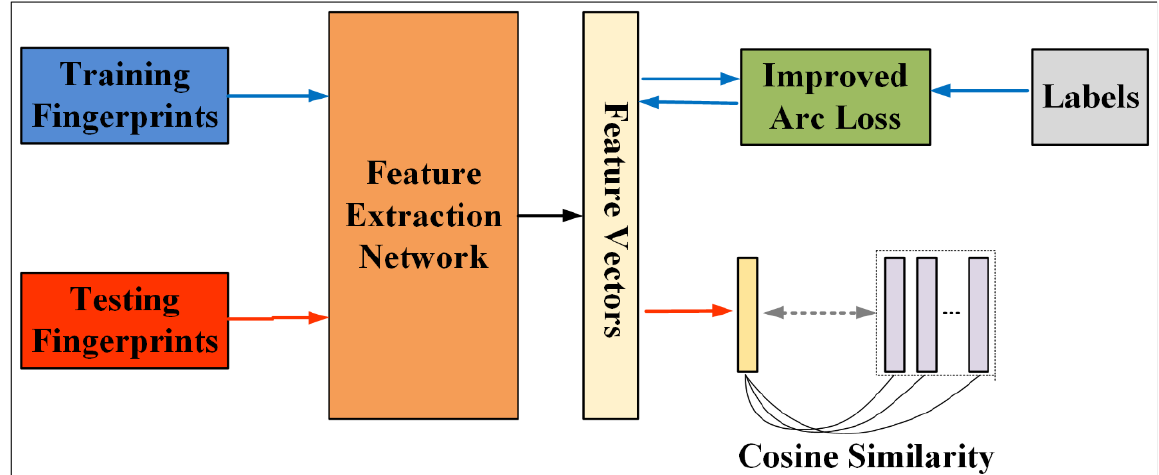
Figure 1. The overall construction of APFI. The model is divided into a training phase (represented by blue arrows in the figure) and a validation phase (represented by red arrows in the figure).